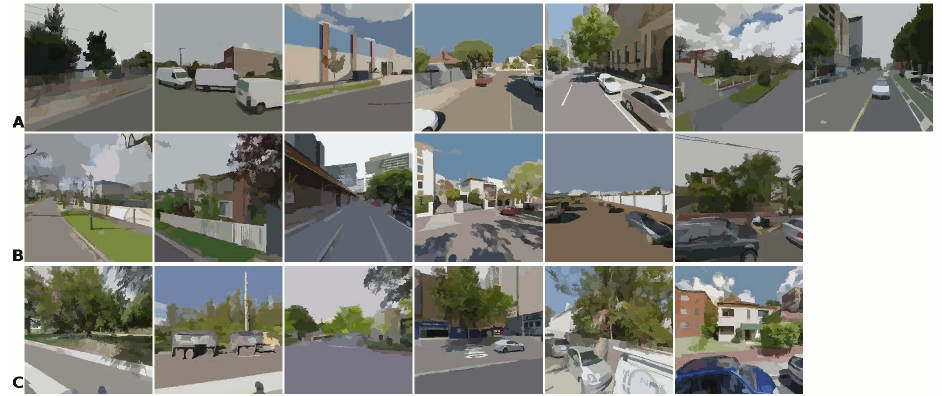
Figure 8. Gallery of “Paris-like” locations in Melbourne ( A and B ) and Sydney ( C ) using the GSV-BSV neural